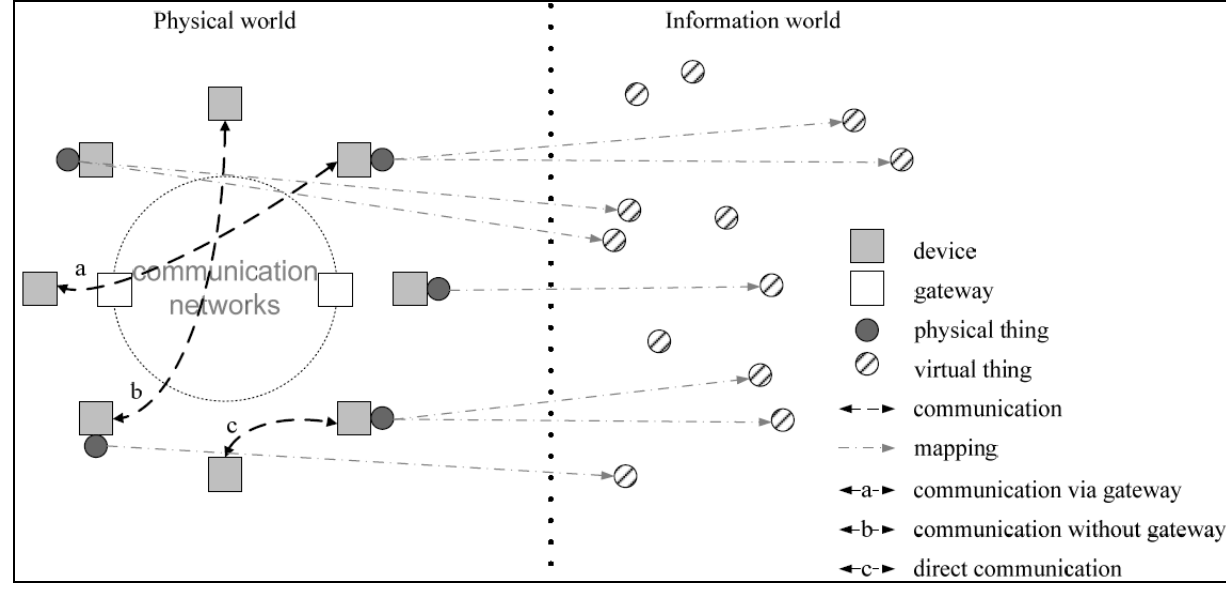
Figure 1. Technical overview of the IoT (Source: Recommendation ITU-T Y.2060—Overview of the Internet of Things